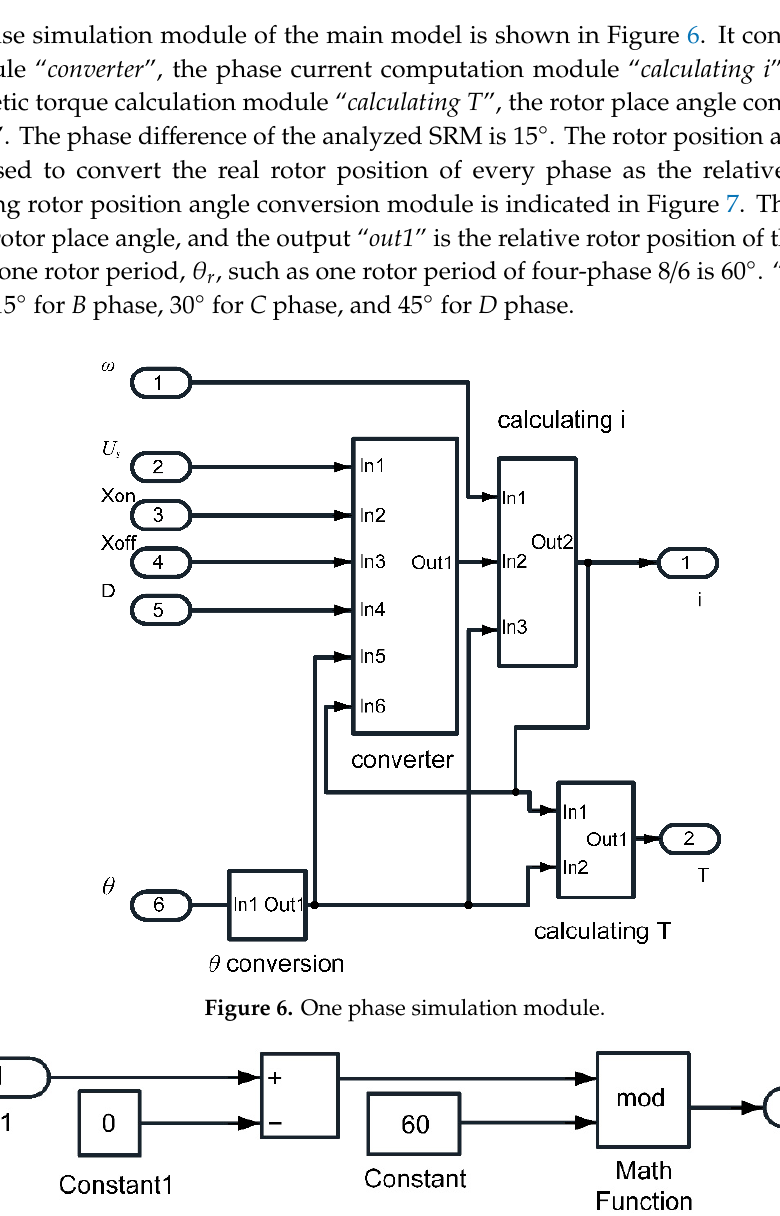
Figure 5. Controller module.